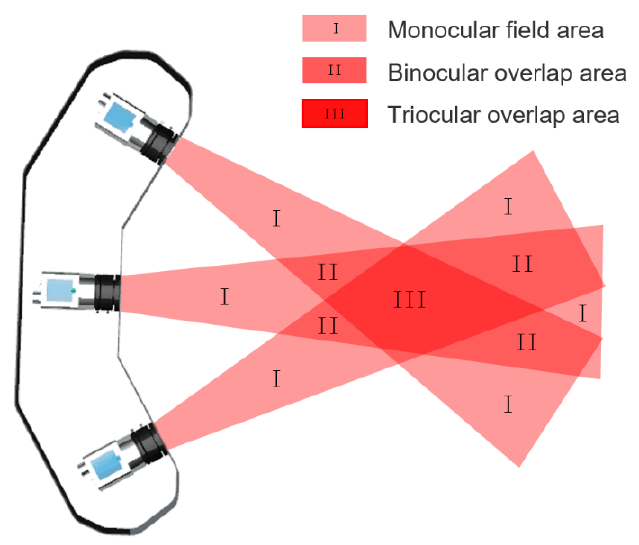
Figure 10. Measurement range of the system.